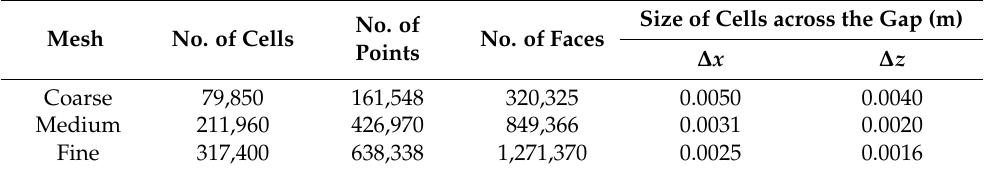
Figure 2. Typical layout of the computational meshes near the two boxes. Table 1. Details of the Coarse, Medium and Fine meshes.